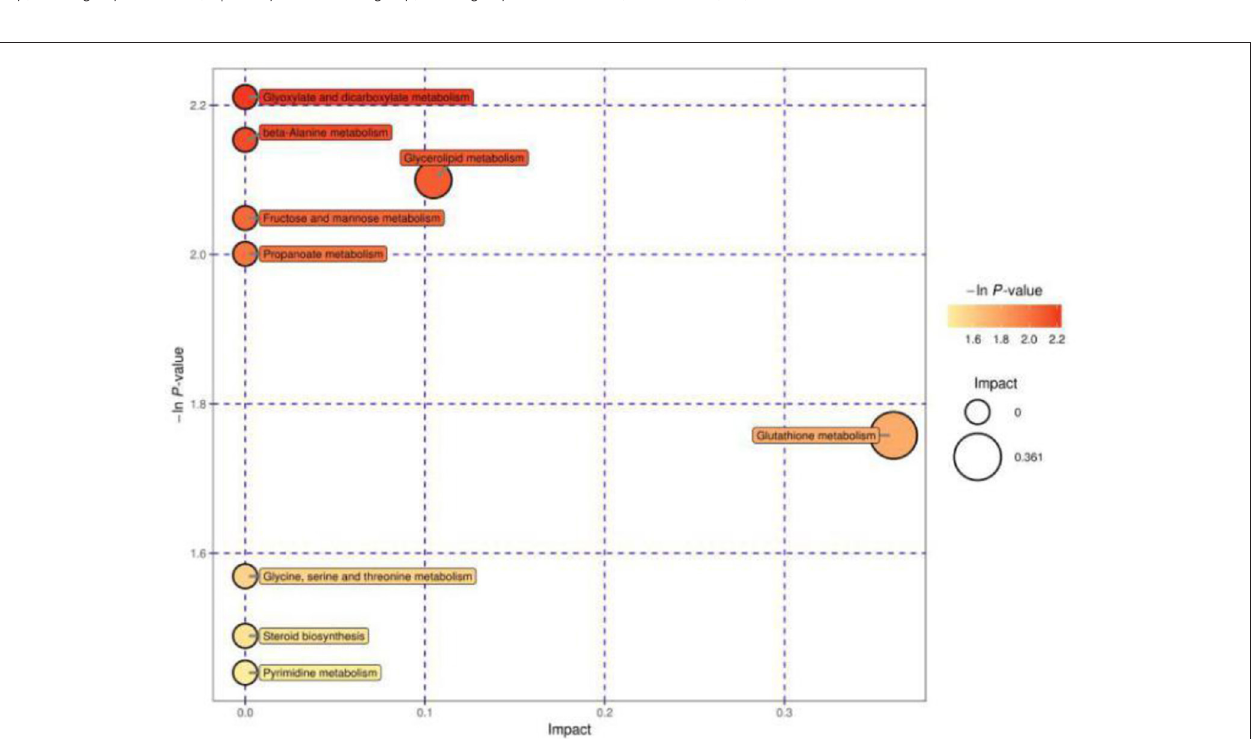
glycerolipid metabolism and glutathione metabolism are shown as darker and larger, indicating that their relative influence is